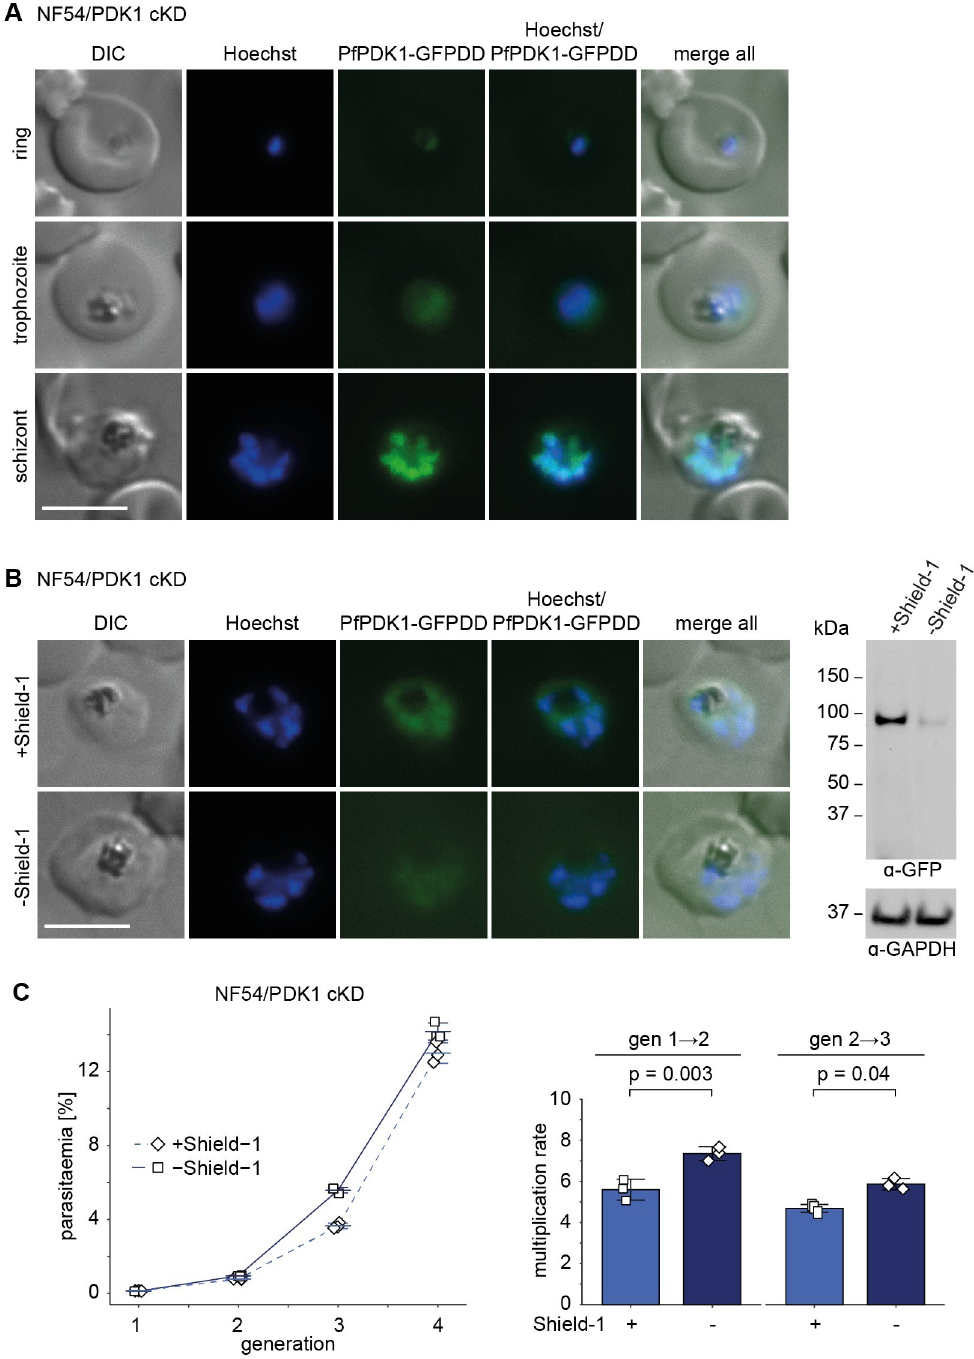
Fig 4. Knockdown of PfPDK1 expression in NF54/PDK1 cKD parasites has no major effect on asexual parasite growth. (A) Expression of PfPDK1-GFPDD in ring (18 to 24 hpi), trophozoite (24 to 30 hpi), and schizont (42 to 48 hpi) stages cultured under protein-stabilising (+Shield-1) conditions by live cell fluorescence imaging. Representative fluorescence images are shown. Parasite DNA was stained with Hoechst. Scale bar = 5 μ m. (B) Expression of PfPDK1-GFPDD under protein-depleting (–Shield-1) and control conditions (+Shield-1) by live cell fluorescence imaging and western blot analysis. Synchronous parasites (0 to 8 hpi) were split ( ± Shield-1) 40 hours before collection of the samples. Representative fluorescence images are shown. Parasite DNA was stained with Hoechst. Scale bar = 5 μ m. For western blot analysis, lysates derived from an equal numbers of parasites were loaded per lane. MW PfPDK1-GFPDD = 101.1 kDa, MW PfGAPDH = 36.6 kDa. The full size western blot is shown in S9 Fig. (C) Increase